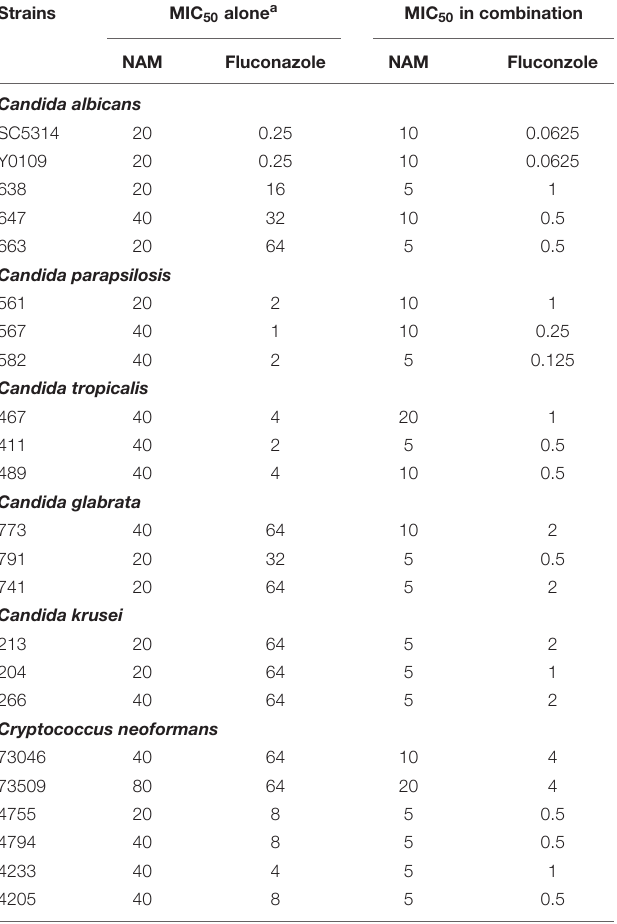
TABLE 1 | Effects of nicontinamide used alone or in combination with fluconazole against fungi. Strains